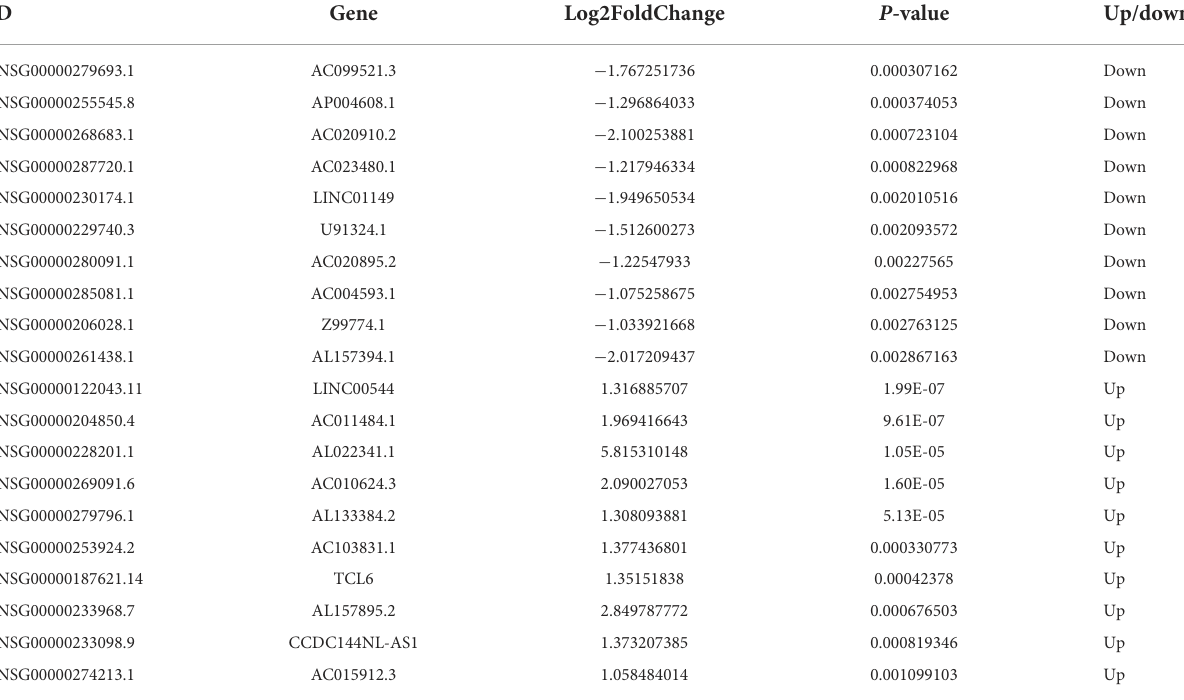
TABLE 3 Top 10 up/down-regulated